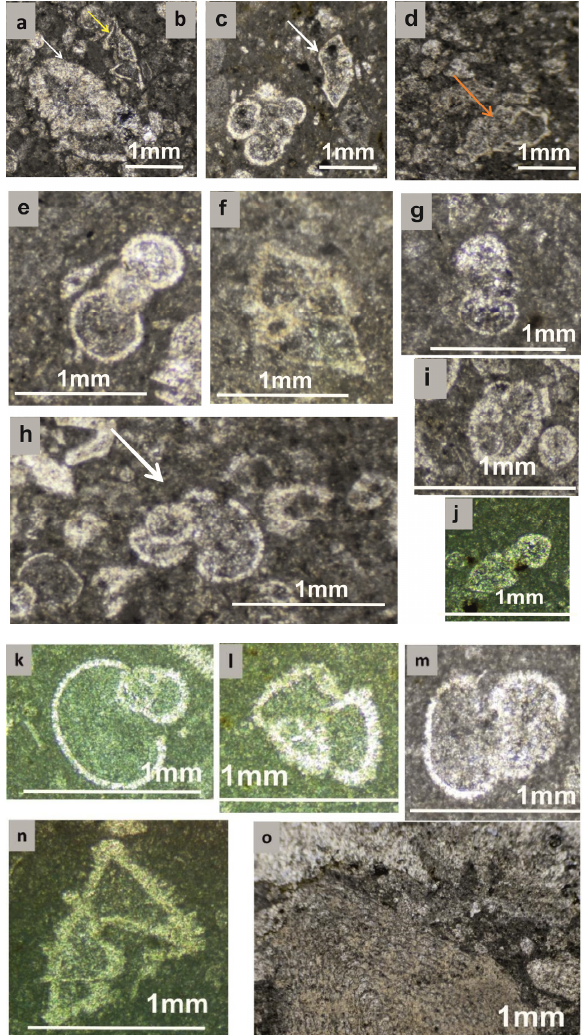
Figure 4. Representative foraminifera species identified from the studied succession. ( a ) Miscellanea miscella (white arrow) ( b ) Morozovella conicotruncana (Eocene) (yellow arrow), ( c ) Globotruncana dupeublei , ( d ) Globotruncana arca , ( e ) Globigerinelloides sp. (Maastrichtian), ( f ) Morozovella formosa (Eocene), ( g ) Subbotina triangularis (Paleocene), ( h ) Turborotalia increbescens (Eocene), ( i ) Globigerinatheka sp. (Eocene), ( j ) Planorotalites chapmani (Paleocene), ( k ) Subbotina linaperta (Eocene), ( l ) Acarinina bullbrooki (Eocene), ( m ) Subbotina velascoensis (Paleocene), ( n ) Morozovella velascoensis (Paleocene), ( o ) Orbitoides media